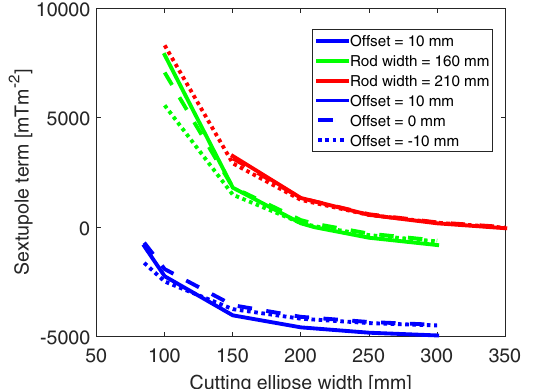
FIG. 16. Sextupole component vs cutting ellipse width for different rod widths and offsets.